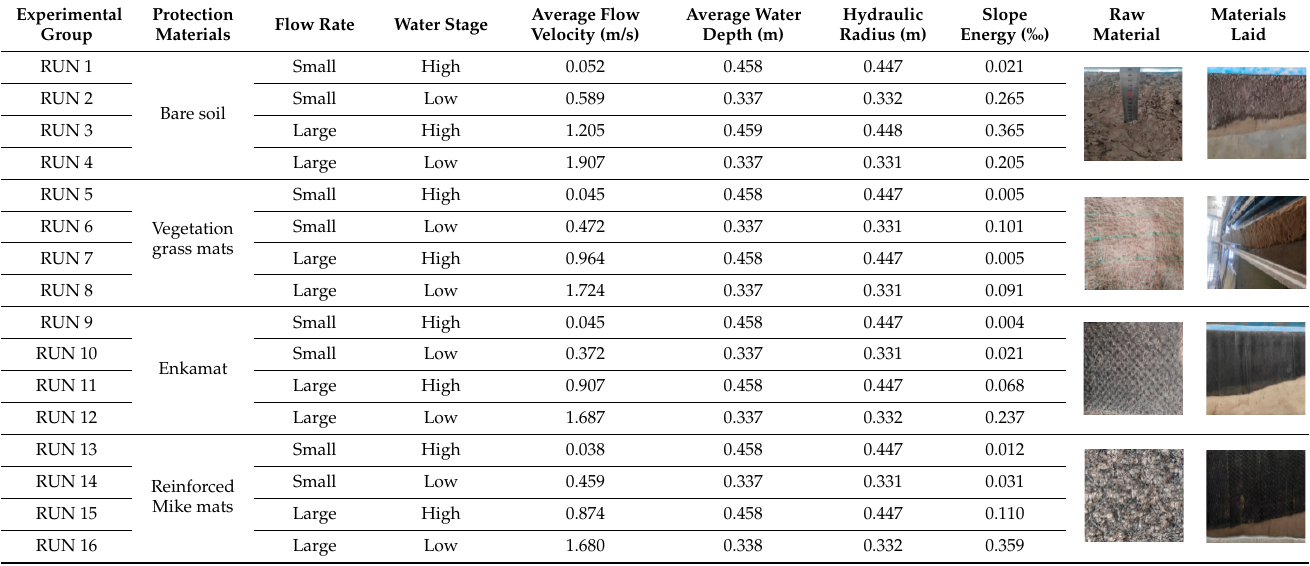
Table 3. List of experimental groups.